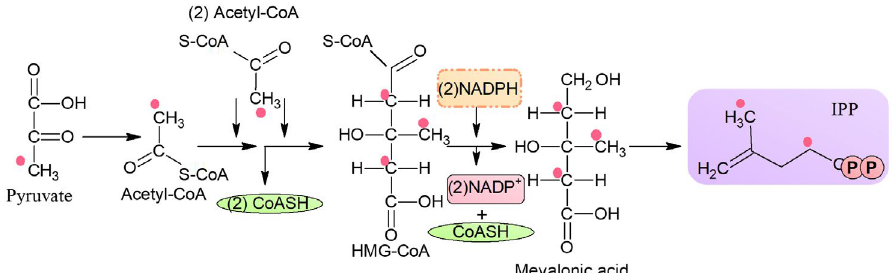
Fig. 3. Steps involved in the biosynthesis of terpenoids via MEP pathway.